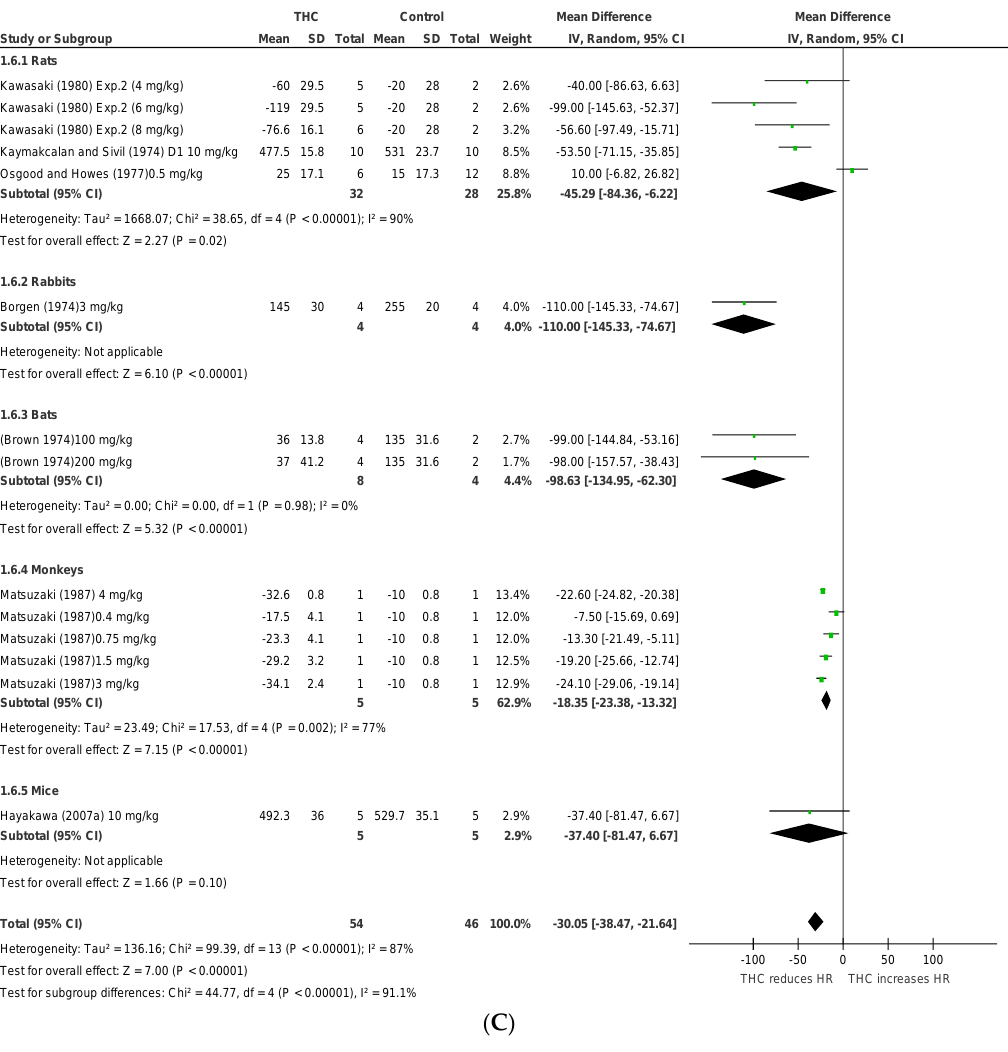
Figure 4. Changes in ( A ) BP, ( B ) HR, and ( C ) blood flow induced by acute THC dosing in conscious animals.